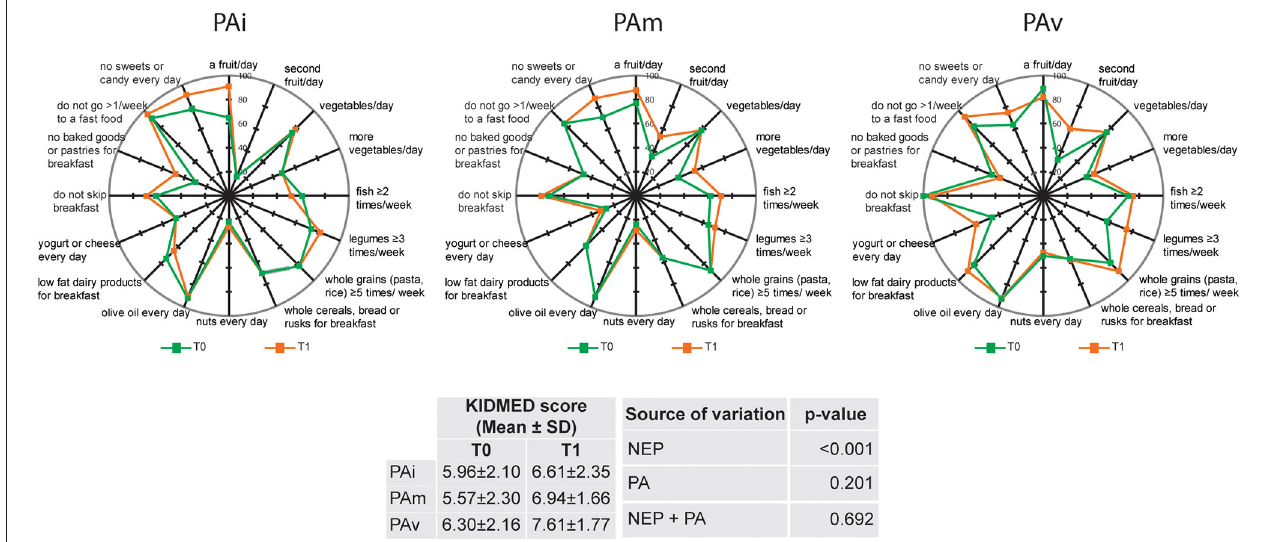
FIGURE 1 | Compliance with items from KIDMED test according to the three physical activity (PA) groups (PAi: inactive; PAm: moderate; PAv: vigorous) at baseline (T0) and after 6 months (T1). The radar chart plots the values of each item of Mediterranean diet score along a separate axis that starts in the center of the chart (0% compliance) and ends at the outer ring (100% compliance). KIDMED score is presented as Mean ± SD; statistical differences were evaluated by two-way repeated-measures ANOVA. NEP, Nutrition Education Program.